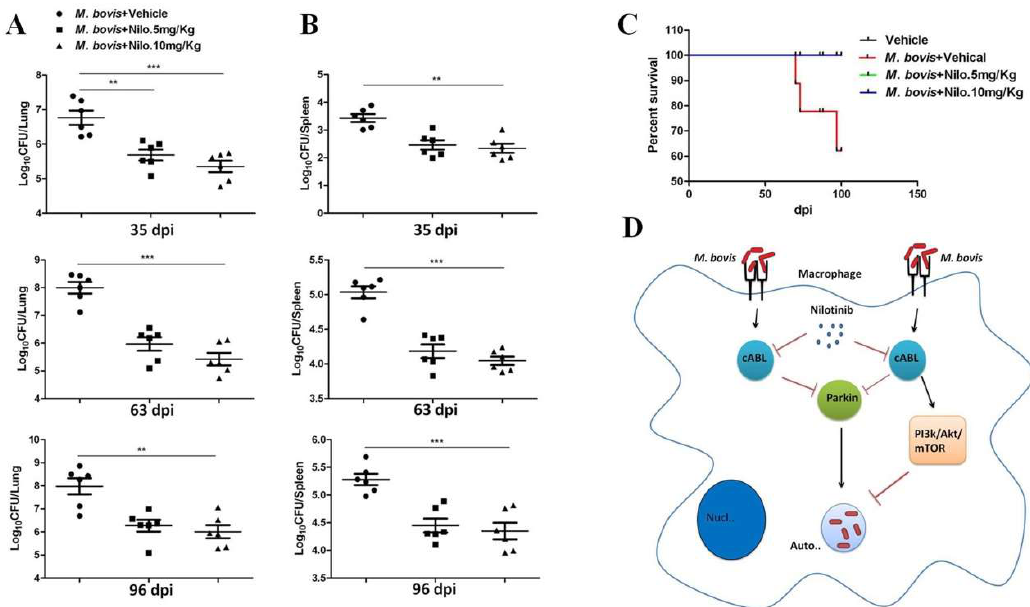
Figure 8. The effect of nilotinib on the growth and survival of M. bovis in infected mice . Lung and spleen tissues were collected at different time points from M. bovis infected mice that were injected with vehicle, nilotinib 5 mg/kg and 10 mg/kg ( n = 6). Viable bacilli were determined by plating ( A ) lung and ( B ) spleen homogenates on 7H11 agar plates after making tenfold dilution in PBS. ( C ) Survival curve of mice following intranasal infection with M. bovis , treated or untreated with nilotinib. Statistical significance was determined by using two-way ANOVA (analysis of variance) followed by Bonferroni’s multiple comparisons. (** p < 0.01, *** p < 0.001). ( D ) A model illustrating how nilotinib modulate autophagy in macrophages infected with M. bovis ; Nilotinib attenuate M. bovis induced activation of PI3k/Akt/mTOR is dependendent on c-ABL. In addition, nilotinib induces M. bovis ubiquitination via parkin-ubiquitin activation.